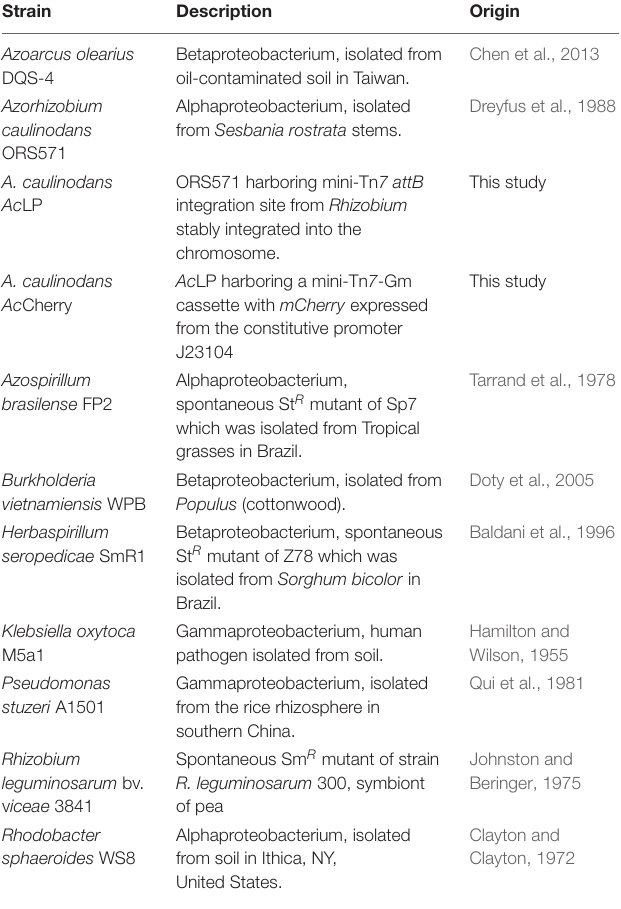
TABLE 1 | Bacterial strains used in this